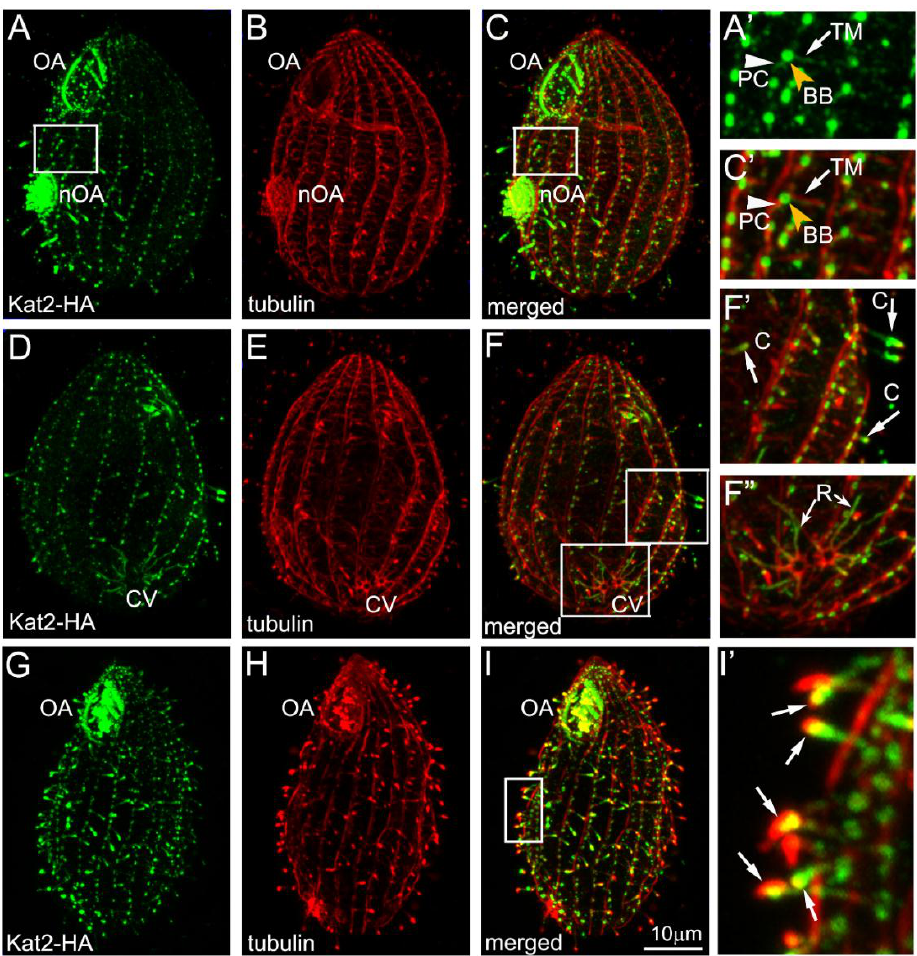
Figure 1. Kat2-HA localizes to microtubular organelles in Tetrahymena . Immunofluorescence confocal images of the ventral ( A – C ) and dorsal ( D – F ) sides of the Kat2-HA-overexpressing cells, showing a co-localization of Kat2-HA ( A , D ) with microtubular structures ( B , E ). ( C , F ) Merged images. Note a predominant localization of Kat2-HA in short growing cilia ( A , C ), especially at their distal ends ( F’ , arrows), near the basal bodies ( A’ , C’ , yellow arrowhead), and weak staining along the transverse ( A’ , C’ , white arrow) and postciliary microtubules ( A’ , C’ , white arrowhead) and along microtubular radial rootlets of the contractile vacuole ( F” , arrows). ( G – I ) Fluorescence confocal images showing Kat2-HA-overexpressing cells with short assembling cilia 30 min. after the experimental deciliation. Note the strong signal of Kat2-HA ( g ) in growing cilia, especially at their tips ( I’ , arrows). ( H ) tubulin staining, and ( I ) merged image. The white rectangles on ( C ), ( F) , and ( I ) images show areas magnified in ( C’ ), ( F’ ), ( F” ), and ( I’ ), respectively. Abbreviations: BB—basal body; C—cilium; CV—contractile vacuole; nOA—new oral apparatus; OA—oral apparatus; PC—postciliary microtubules; R—radial rootlets of the contractile vacuole; TM—transverse microtubules. Bar = 10 μm.